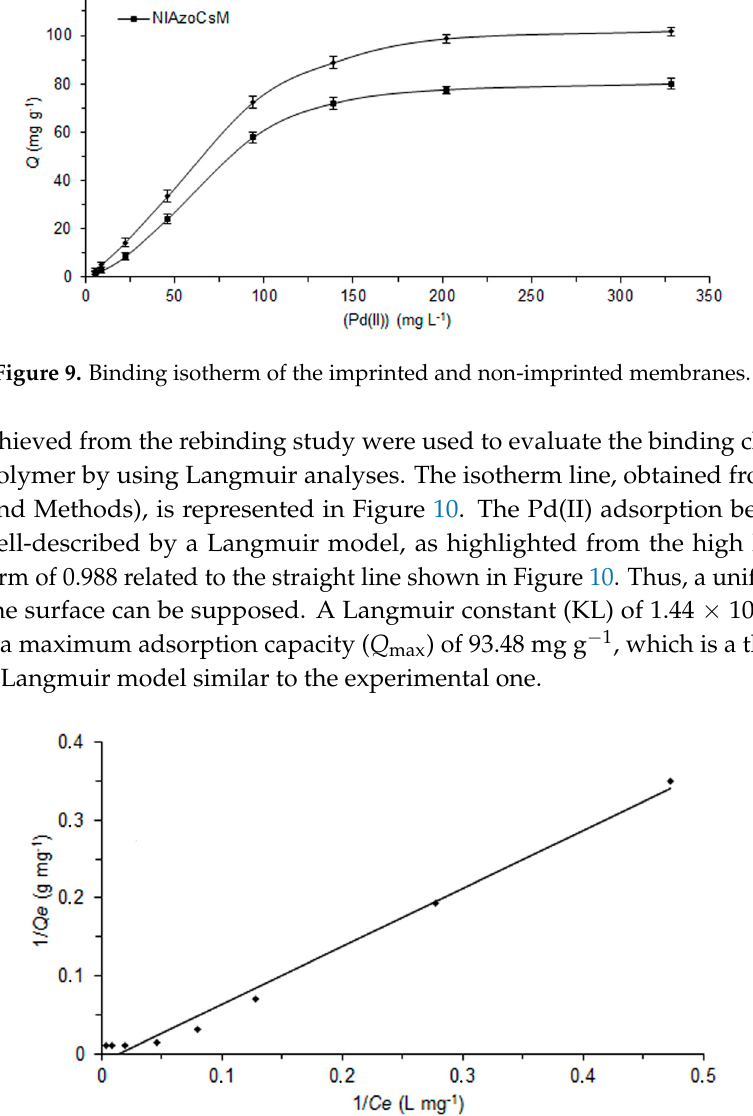
Figure 10. Langmuir isotherm of imprinted membrane Pd-IAzoCsM with equation y = 0.7431 x − 0.0107.